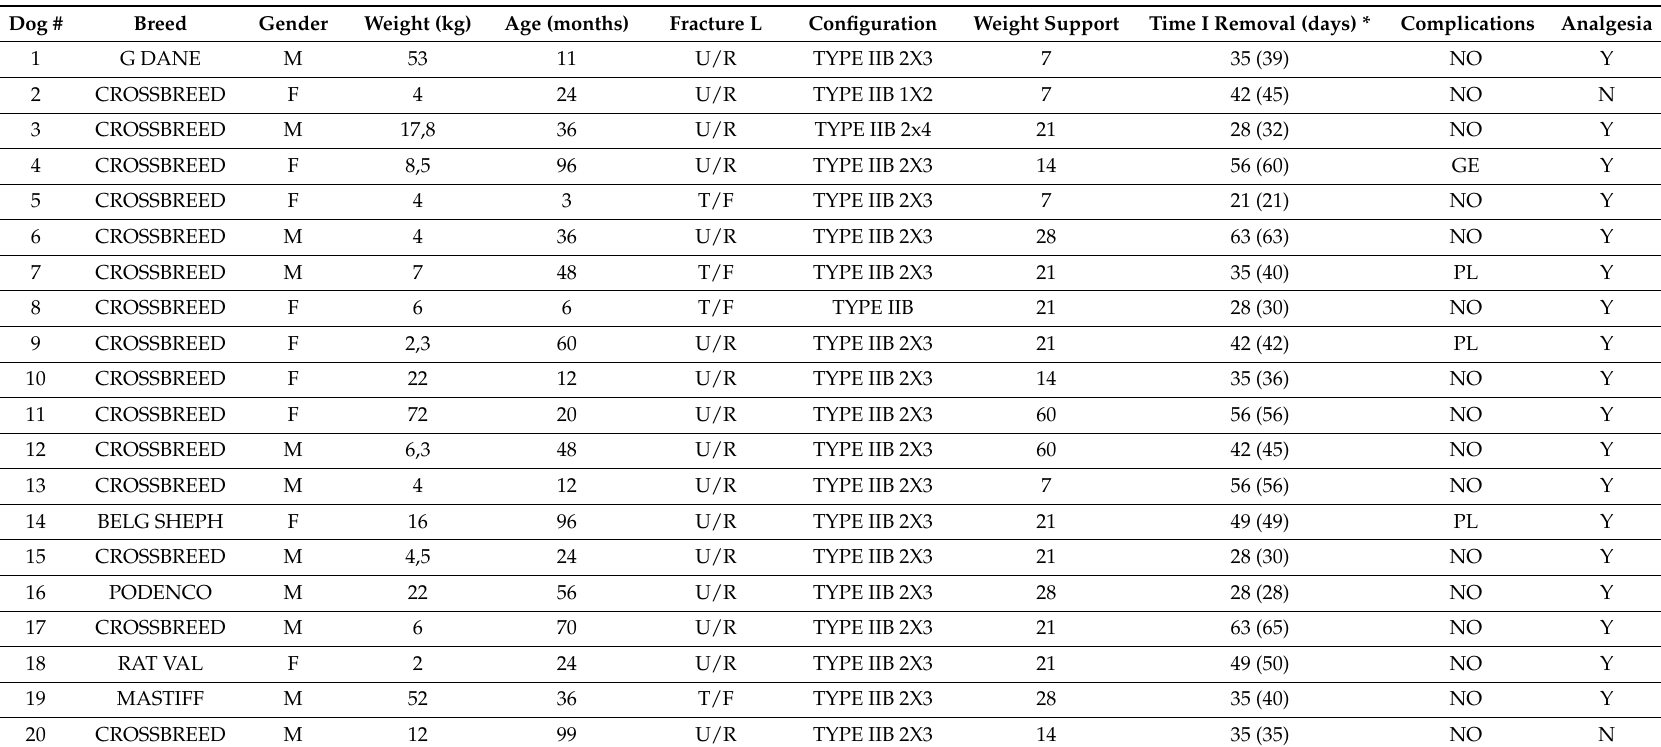
Table 1. Individual data and main results for PRGF